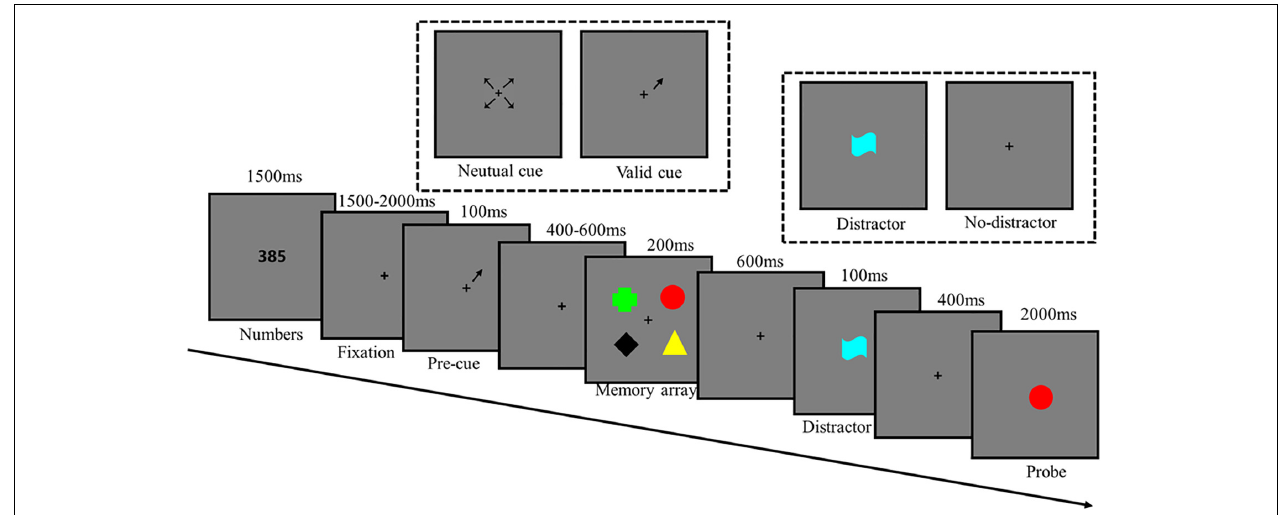
FIGURE 1 | Schematic illustration of the trial procedure.